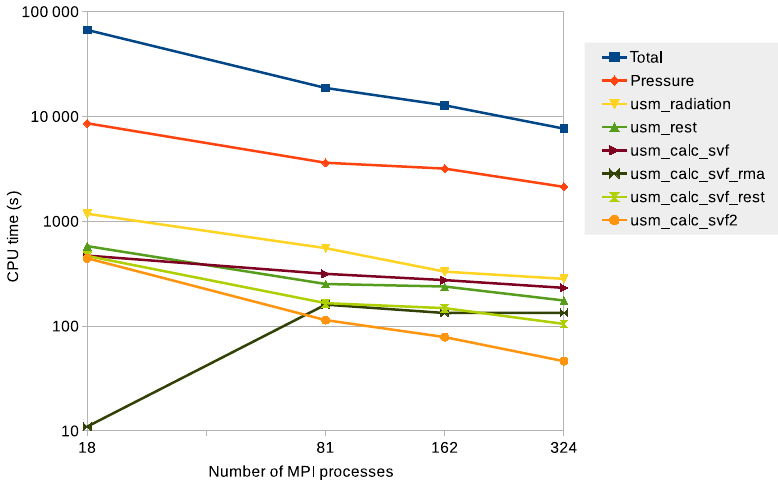
Figure 21. Comparison of the calculation time spent in model PALM-USM and in its chosen parts for various numbers of cores. Model configuration and the meaning of items is the same as in Fig. 20; additionally, usm_calc_svf_rest shows the difference usm_calc_svf–